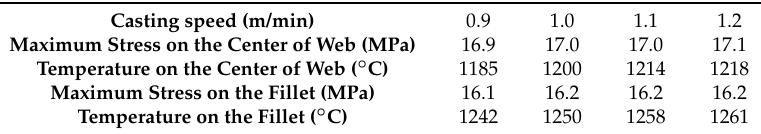
Table 1. Maximum stress and its temperature at different casting speeds.